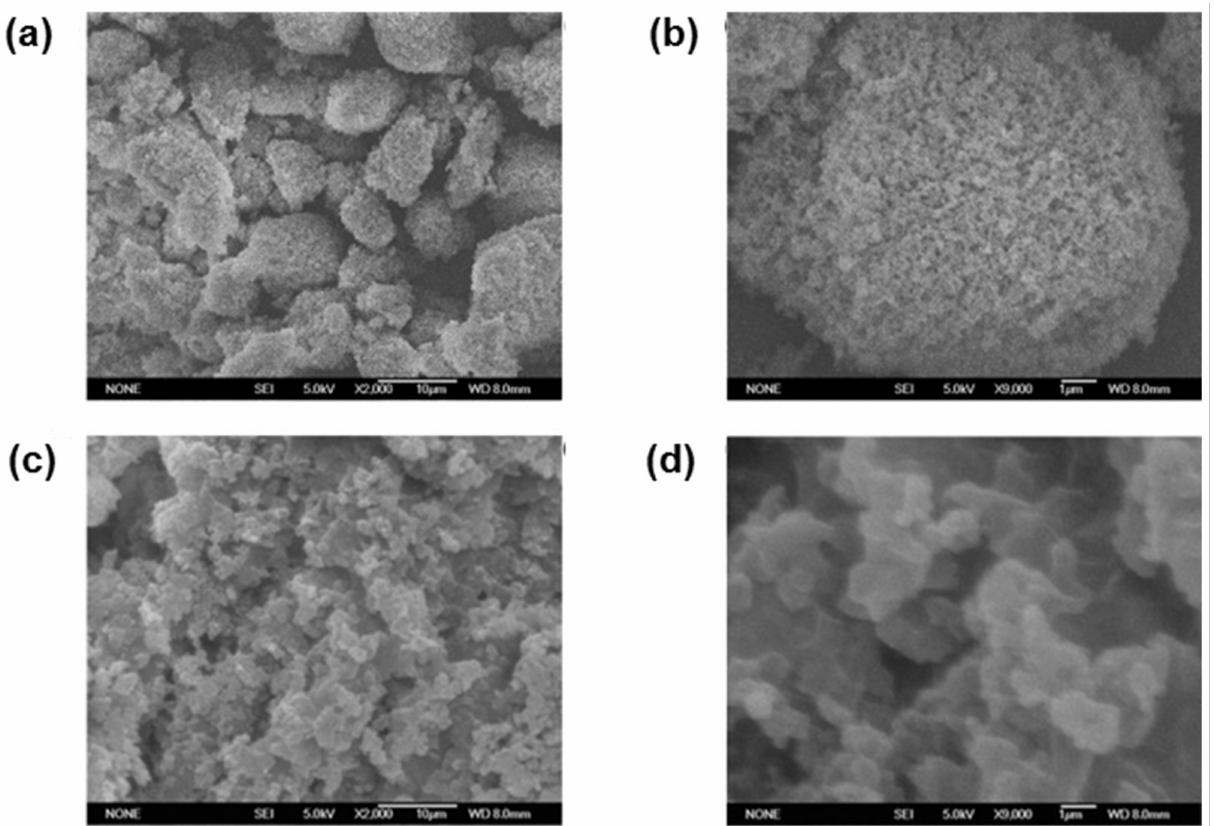
Figure 6. SEM images of hypericin-based ( a , b ) MIP and ( c , d ) NIP [77]. The morphology of MIP and NIP particles by Granados et al. [88] showed in Figure 7A shows SEM images of MIP particles made from crushed polymer monoliths generated by bulk polymerization, of which possess a non-spherical shape (A). On the imprinted Figure 7B and non-imprinted surfaces Figure 7C, the textural surface of the polymers exhibits a typical pattern (C). The NIP, on the other hand, possesses a distinct roughness and a smoother surface. Similarly with Huang et al. [90] that investigated the use of propyl gallate (PrG) as a template in a MIP cartridge. Shows that the morphology of MIP displayed a rougher and more porous surface compared to NIP. Sanagi et al. [91] also reported that the surface morphology and image of the MIP had rough surface with an irregular order. As the pore sizes of the samples ranged from 2 to 50 nm, the polymers were classified as mesoporous.